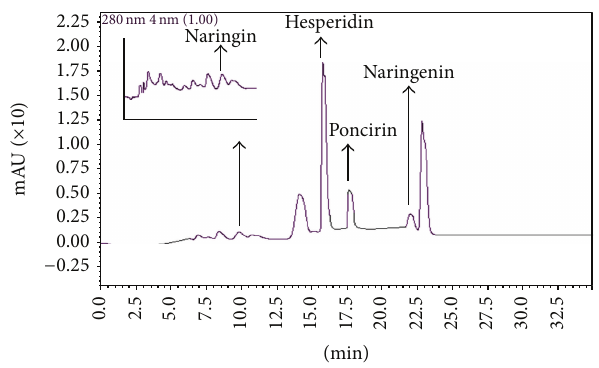
Figure 2: Characteristic HPLC-DAD chromatogram of samples of Brazilian orange